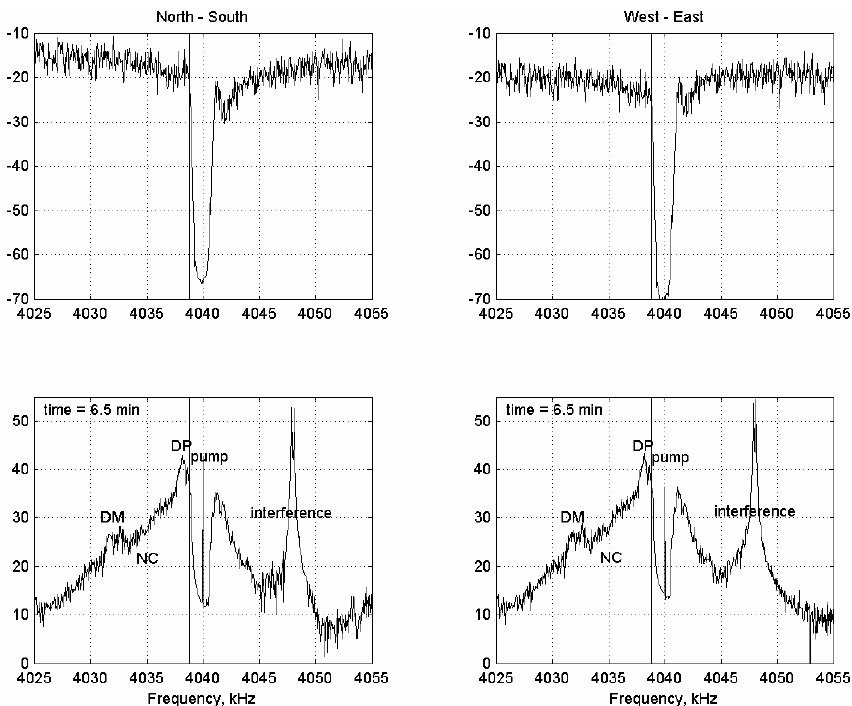
Fig. 4. These plots show cross power (unnormalized coherence) curves calculated from raw voltage samples from the north–south (left panels) and west–east (right panels) receiver pairs. The top row of spectra were made using a noise generator with the 4040-kHz notch filters connected to each receiver. The bottom panels show the corresponding experimental SEE cross power spectra, measured 6.5 min after the pump on time at 15:30 UT on 6 October 2004, using the 4040-kHz notch filters with the pump transmitting at 4040kHz. The vertical line is plotted at 4038.8kHz, slightly below the filter cutoff